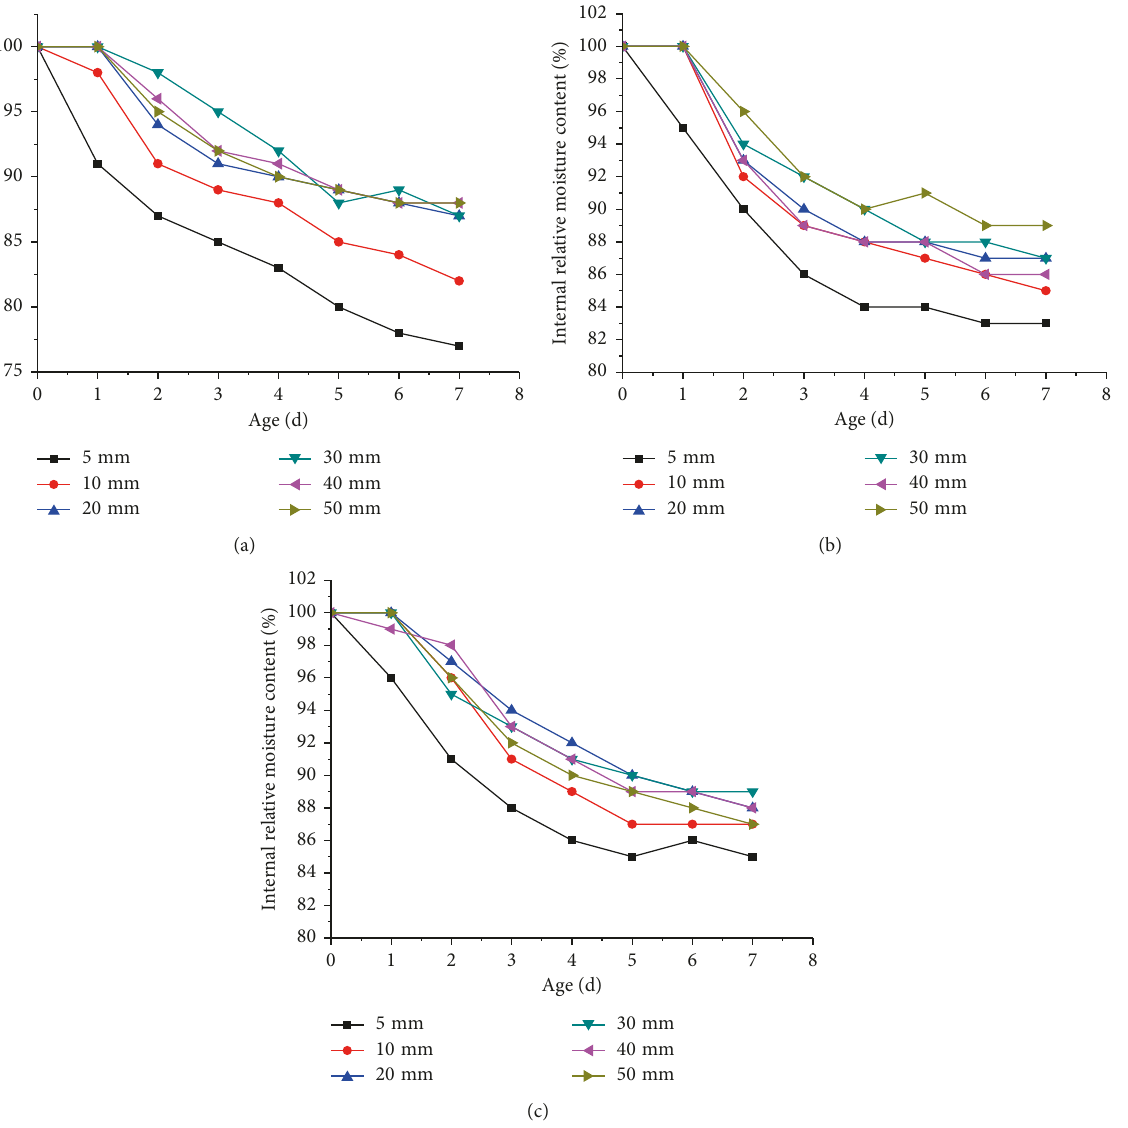
Figure 5: Internal relative moisture content of concrete under 20 ° C, 60% RH. (a) No CPF liner. (b) Lateral surfaces covered by CPF liner. (c) Three surfaces covered by CPF